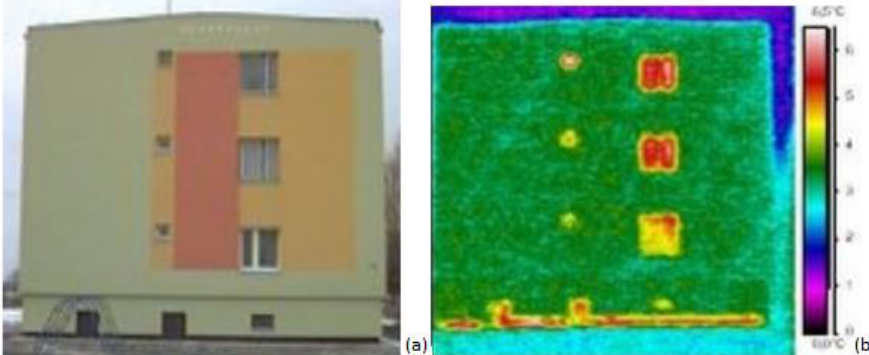
Figure 3. Representative image of ( a ) one of few hundreds explored buildings and ( b ) its thermogram indicating residual heat flows after thermomodernization. Table 1. Characteristics of potential variables influencing the energy needs of buildings undergoing thermal efficiency improvement.